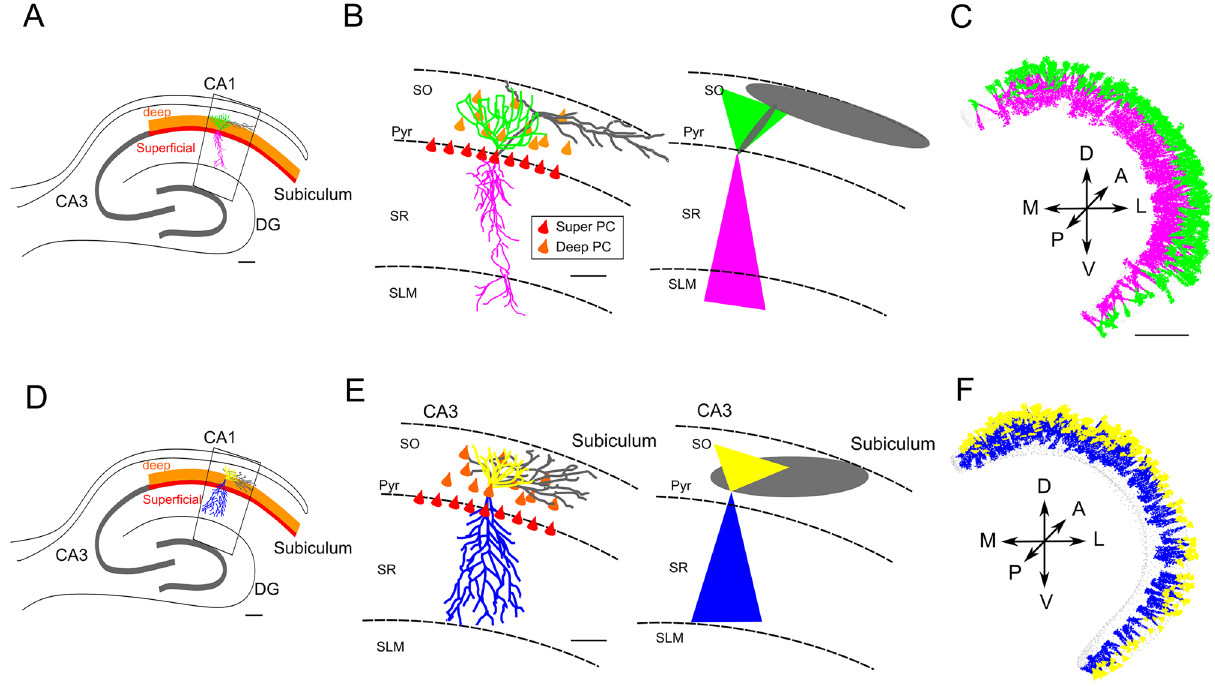
Figure 4. ( A ) Schematic illustration of a transversal section of the hippocampus with major regions. Colored lines illustrate the deep (orange) and superficial (red) subdivisions of the CA1 Pyramidal layers. Inset shows the CA1 region highlighted in panel ( B ). ( B ). left panel; Realistic morphology of a superficial PC (basal dendrites in green, apical in pink, and axon in gray), oriented within a region of a transversal CA1 hippocampal slice (inset of panel A ). Red triangles correspond to PC soma location within the stratum pyramidalis whereas orange triangles represent the scattered distribution of deep PCs within the SO. right panel; the probability clouds are represented as two triangles (2D of a cone) and an ellipse (2D of an ellipsoid) (color code respects the realistic morphology). ( C ) Reconstruction of dendritic probability clouds of 400 superficial PCs automatically generated and oriented according to cell placement within the CA1 volume. ( D ) Schematic illustrating transversal section of the hippocampus with major regions. Colored lines illustrate the deep (orange) and superficial (red) subdivisions of the CA1 Pyramidal layers. Inset shows the CA1 region highlighted in panel ( E ). ( E ). Similarly to B, a realistic morphology of a deep PC (basal dendrites in yellow, apical in blue, and axon in gray) oriented within a region of a transversal CA1 hippocampal slice (inset of panel D ). The corresponding probability clouds are represented on the right respecting the color code. ( F ) Reconstruction of dendritic probability clouds of 400 deep PCs automatically generated and oriented according to cell placement within the CA1 volume. Scale bars in µm (40 in A and D , 100 in B and E , 1000 in C and F